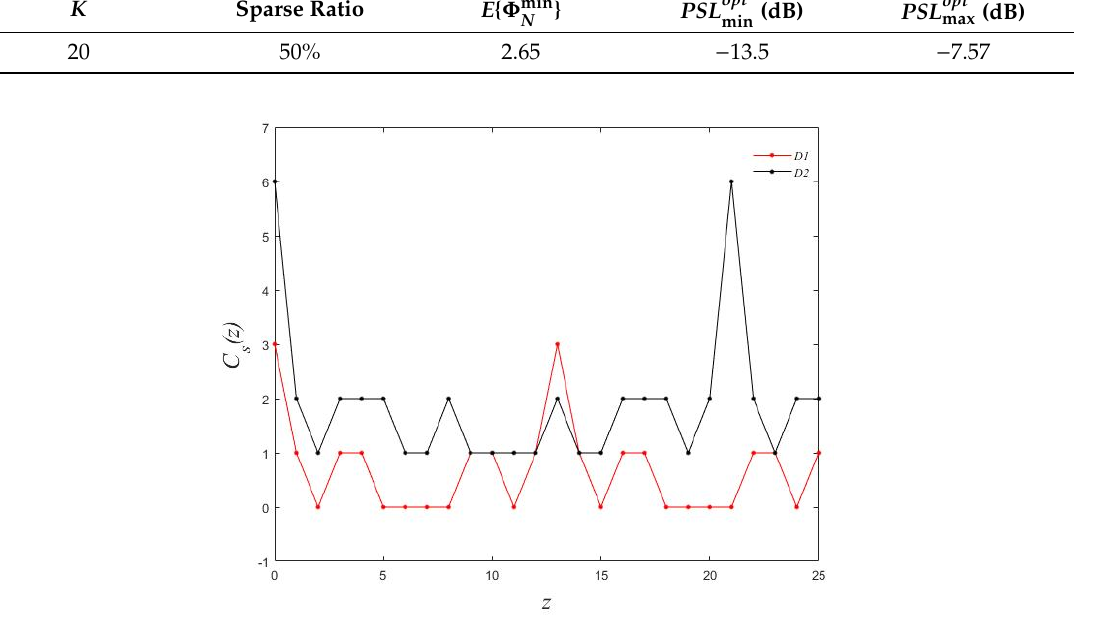
Figure 1. Autocorrelation function